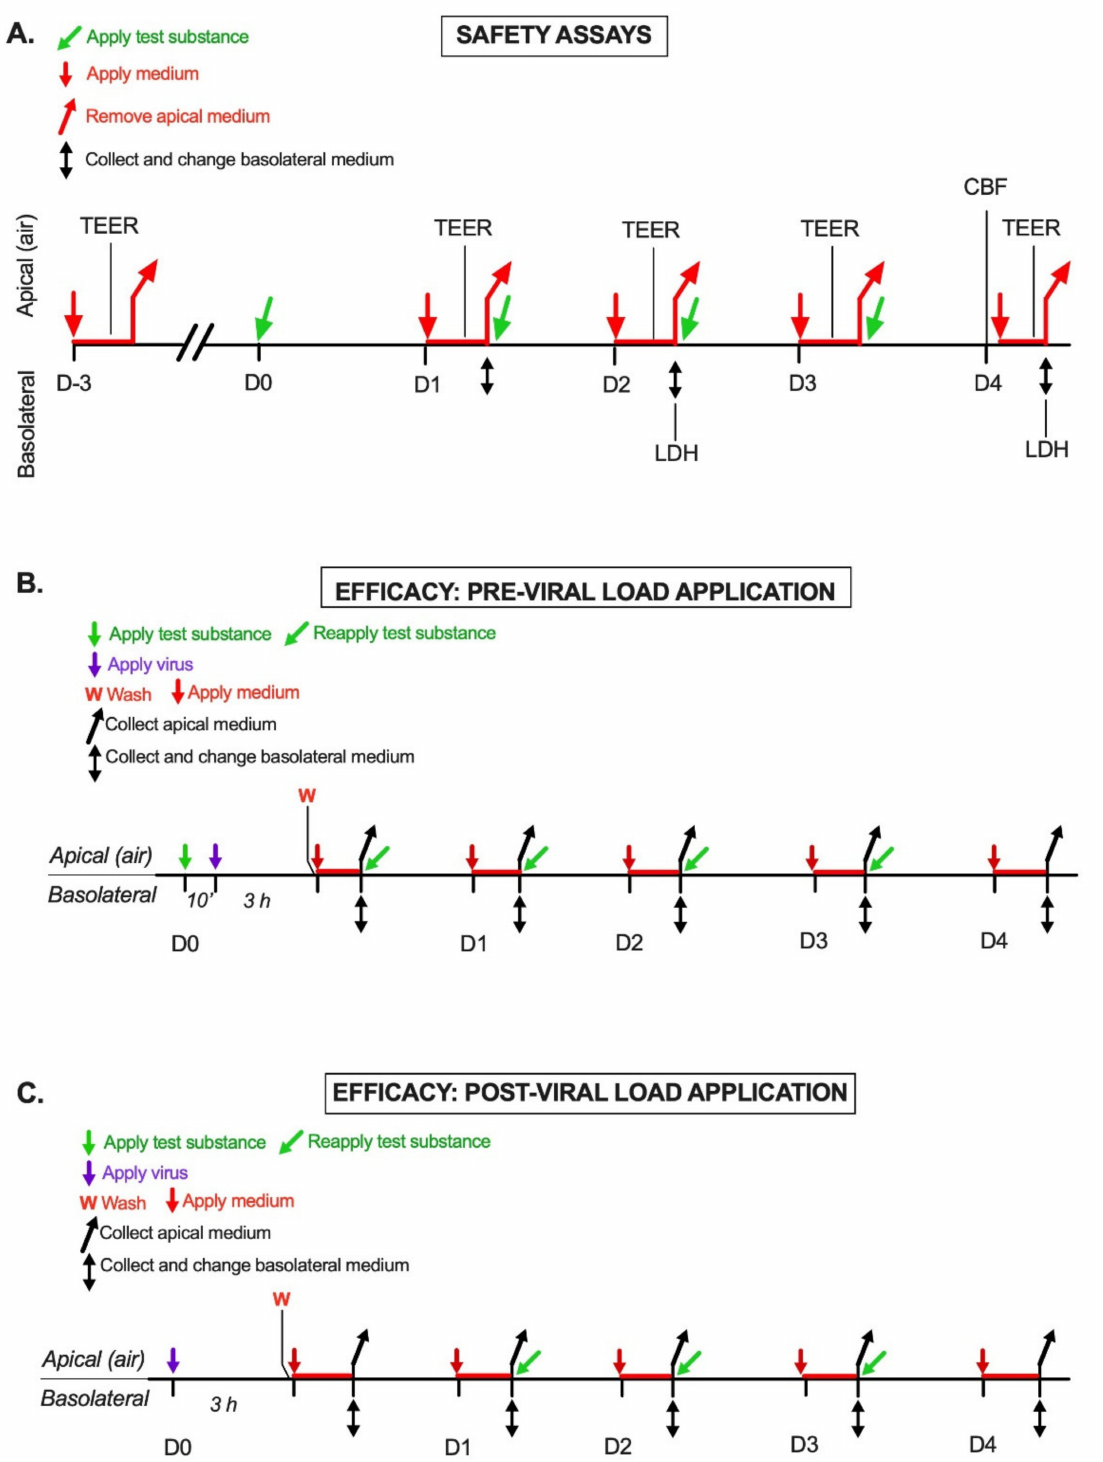
Figure 4. Schematics of experimental protocols. ( A ) Safety assay experimental design. CBF, cilia beating frequency; LDH, lactate dehydrogenase; TEER, transepithelial electric resistance. ( B ) Efficacy assay: Pre-viral load application (Prophylaxis). ( C ) Efficacy assay: Post-viral load application